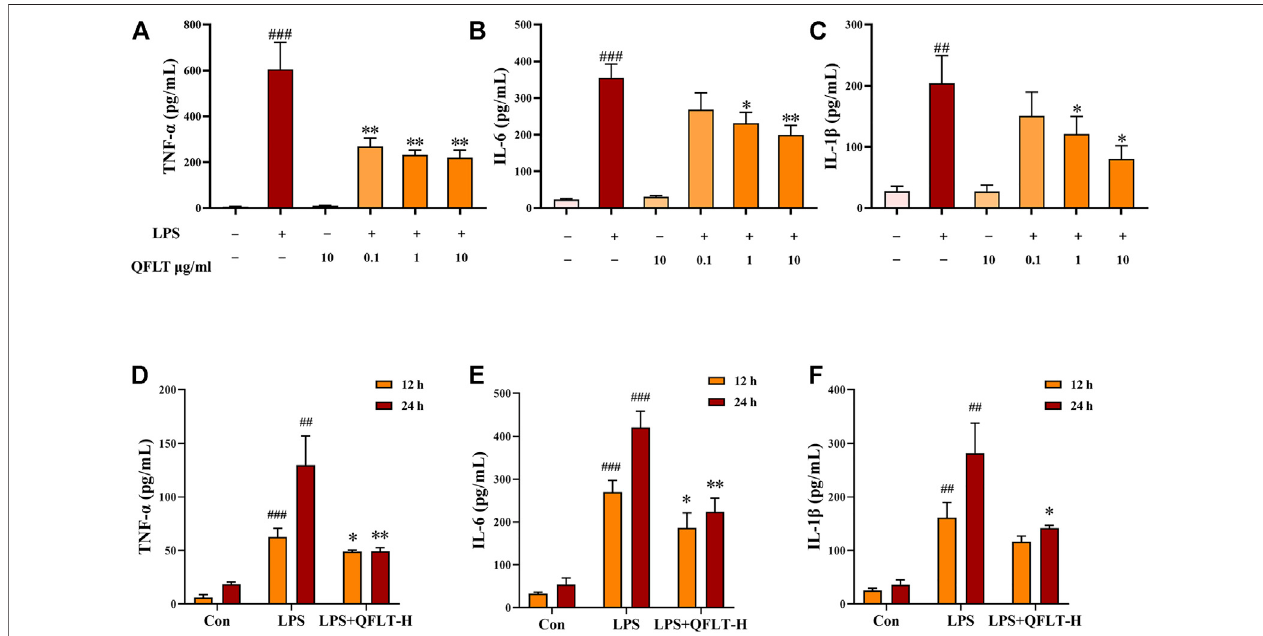
FIGURE 9 | Effects of QFLT treatment on secretion of proin fl ammatory cytokines (TNF- α , IL-1 β and IL-6) of LPS-activated macrophages in vitro (A – F) . Macrophageswereincubatedwith/withoutLPS(5 μ g/ml)intheabsenceorpresenceofQFLT(0,0.1,1,10 μ g/ml)for24 h.Thenthesupernatant wasdetectedusingan ELISA kit. Data were expressed as the mean ± SD ( n = 3). ## p < 0.01 vs. the control group; * p < 0.05 vs. the LPS